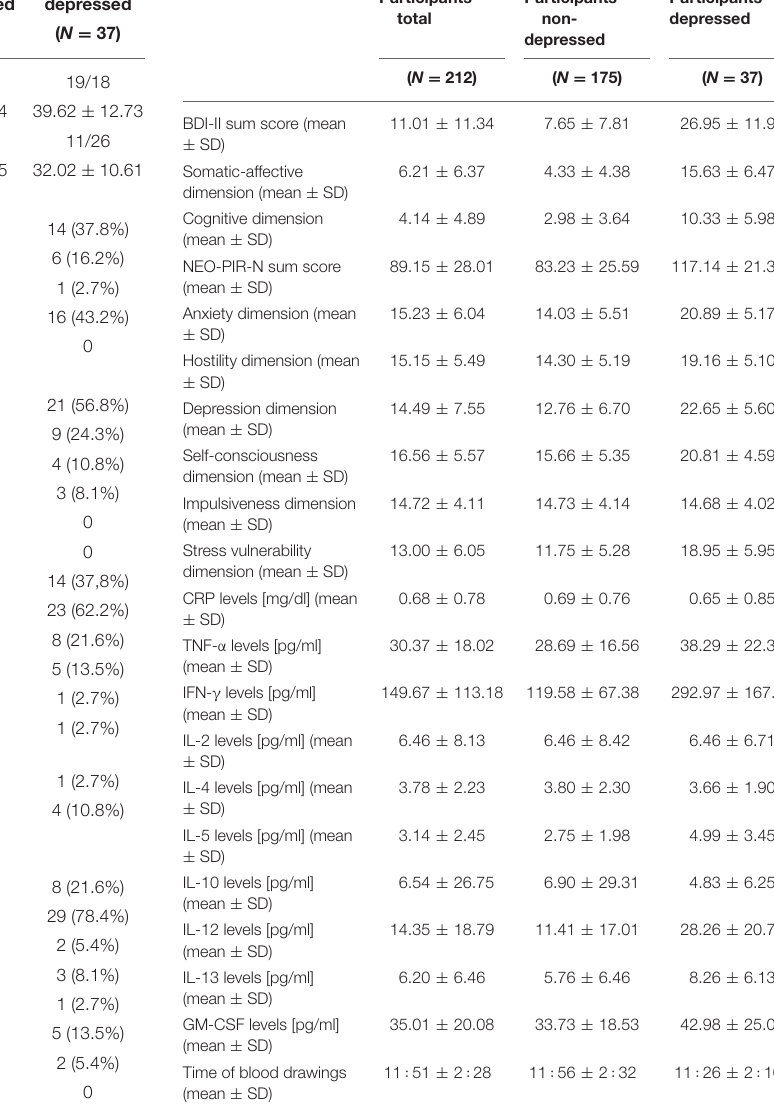
TABLE 2 | Sum total and dimension scores for depression and neuroticism, and concentrations of markers of inflammation in the total sample, and for participants with and without a diagnosis of major depression,